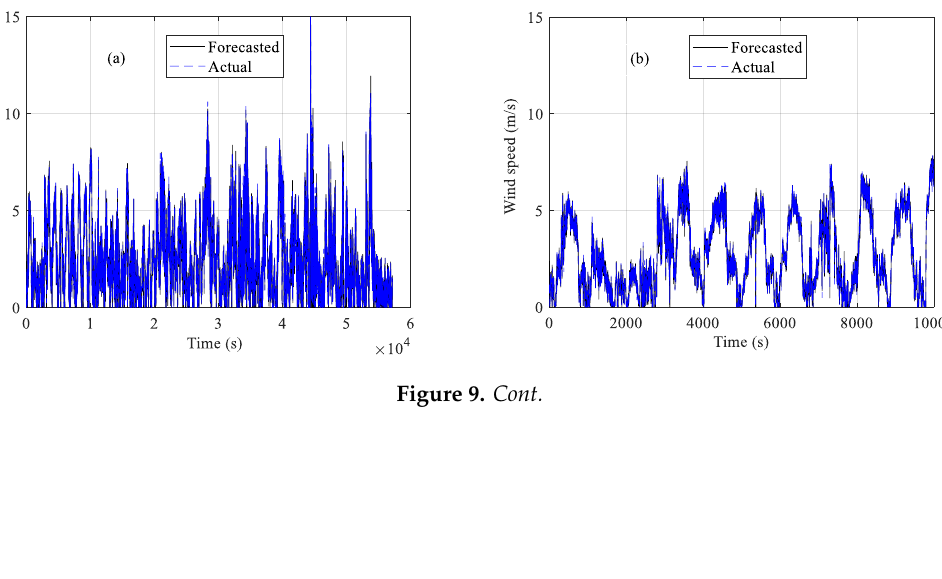
Figure 8. Absolute error per wind direction of the proposed model corresponding at ( a ) Case#2 and ( b ) Case#5 of the 1-min-ahead prediction horizon.